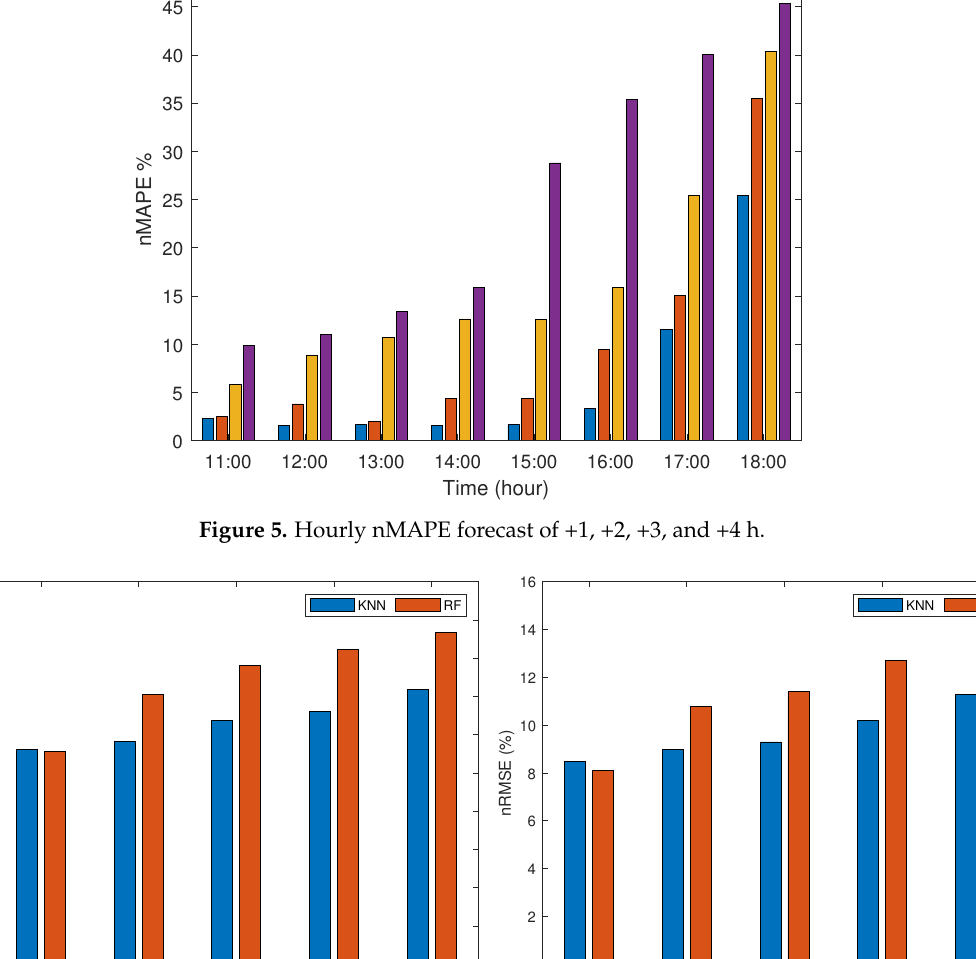
3.1%, 14.3%, and 20.5%, respectively. Furthermore, Figure 7d illustrates the effect of the rapid